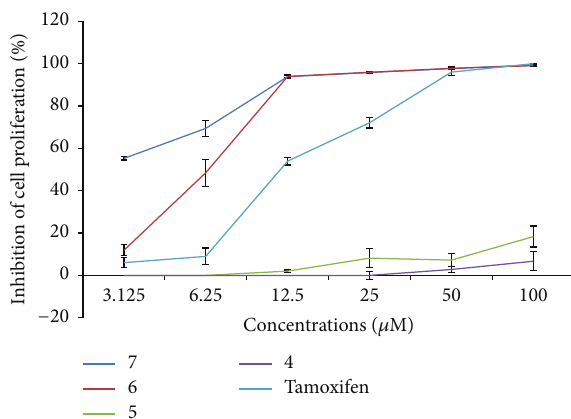
Figure 5: Antiproliferation effect of test compounds on MCF-7 cell line was assessed by MTT assay. The figure depicts dose-dependent activity of test complexes ( 6 - 7 ). The activity of silver complexes was found significant, whereas respective salts ( 4 - 5 ) showed mild to inactive cytotoxicity (values are represented as mean ± SD n =